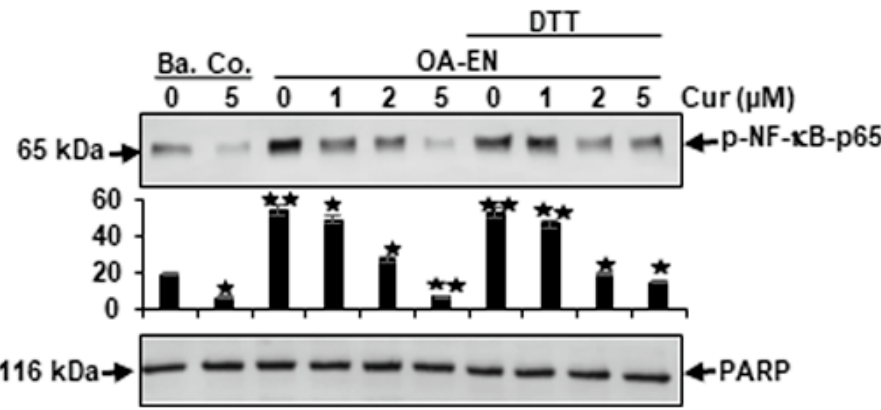
Figure 6. Influence of curcumin on direct association of the p-NF-kB-p65 on DNA in chondrocytes grown in OA-EN. Serum-starved chondrocytes in alginate cultures of OA-EN were handled as outlined in Materials and Methods. Results presented of a minimum of three independent assays, and PARP, a housekeeping protein, was used as a loading control. The densitometric assay was applied to p65-NF-kB. ★ p < 0.05, ★★ p < 0.01.